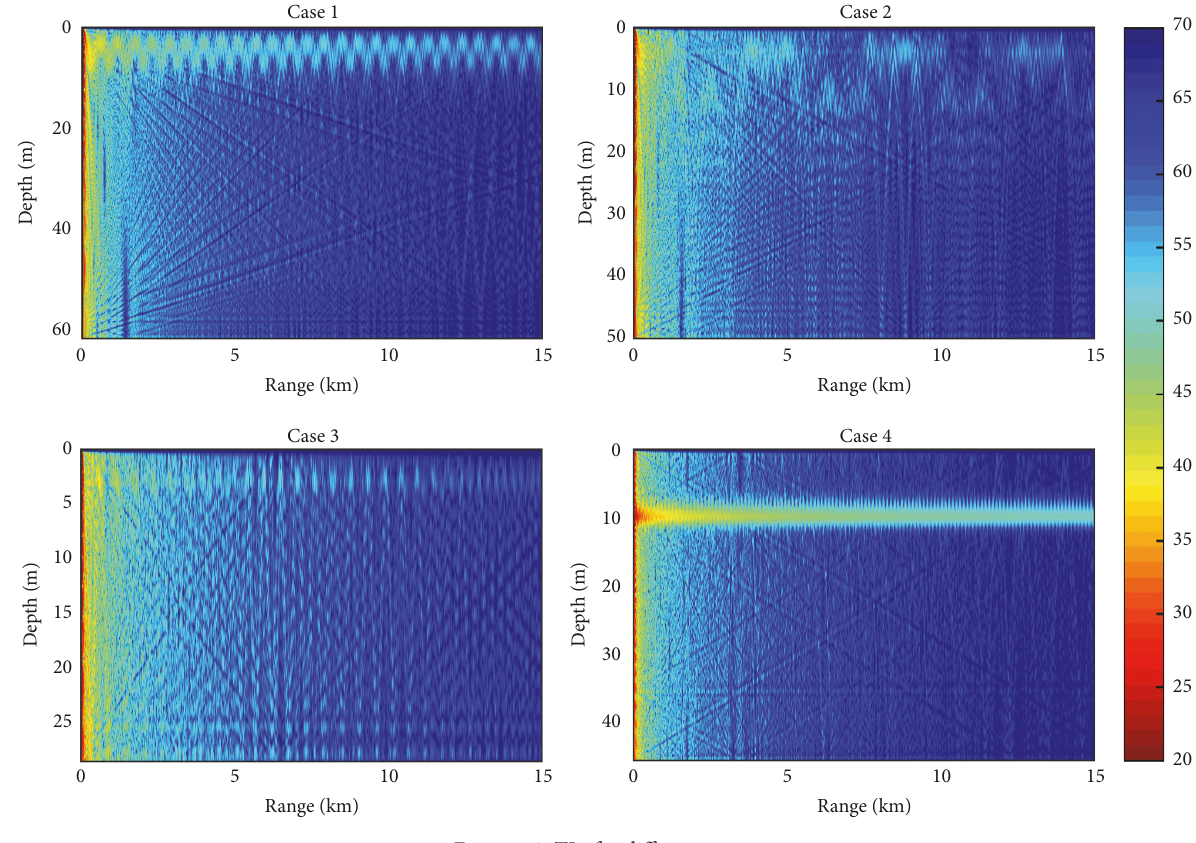
Figure 10: TLs for different